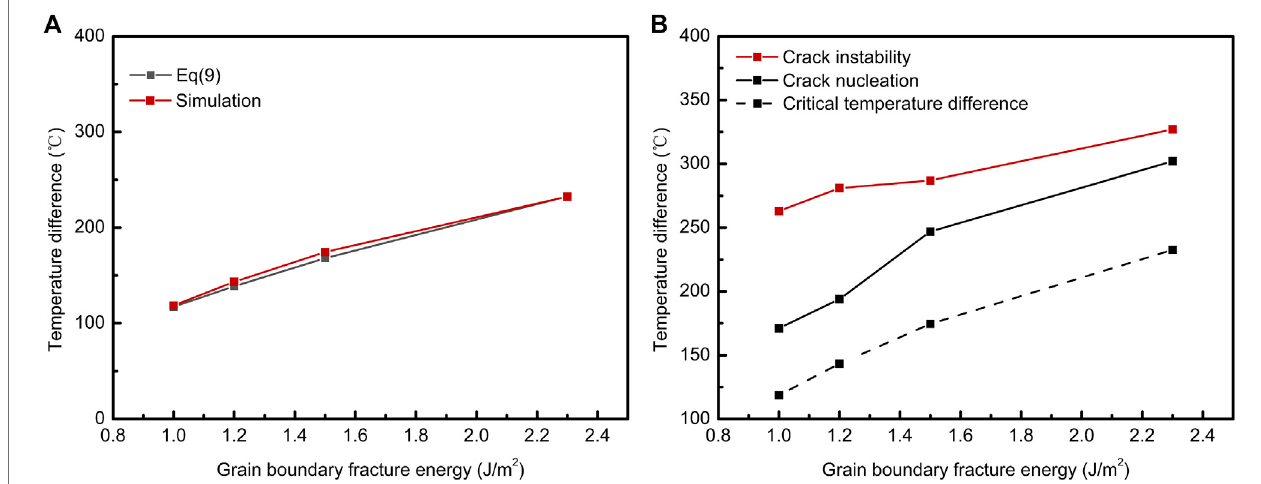
FIGURE12|(A) R calculated from Eq. 9 and thecritical stresstemperature difference obtained from simulation withdifferent grainboundaryfractureenergies; (B) temperature difference of critical stress, crack nucleation, and crack instability with different grain boundary fracture energies.